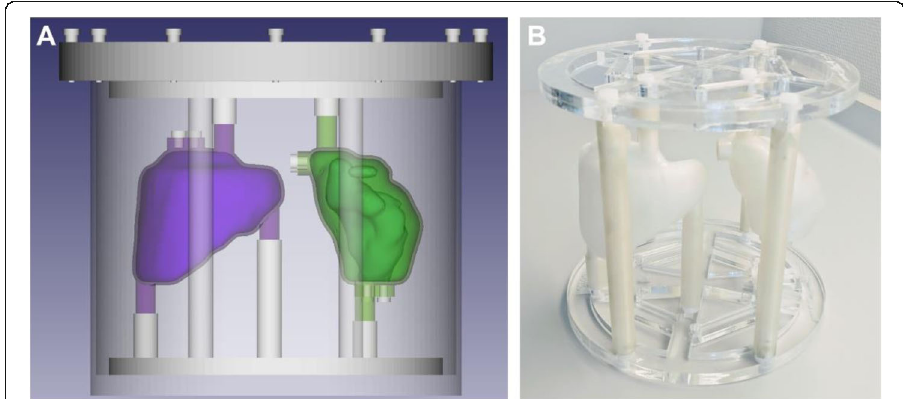
Fig. 1 Two-organ ICRP 110 phantom. A Computer-aided design (purple: one-compartment spleen, green: two-compartment kidney). B 3D printed phantom inserts mounted in the support frame